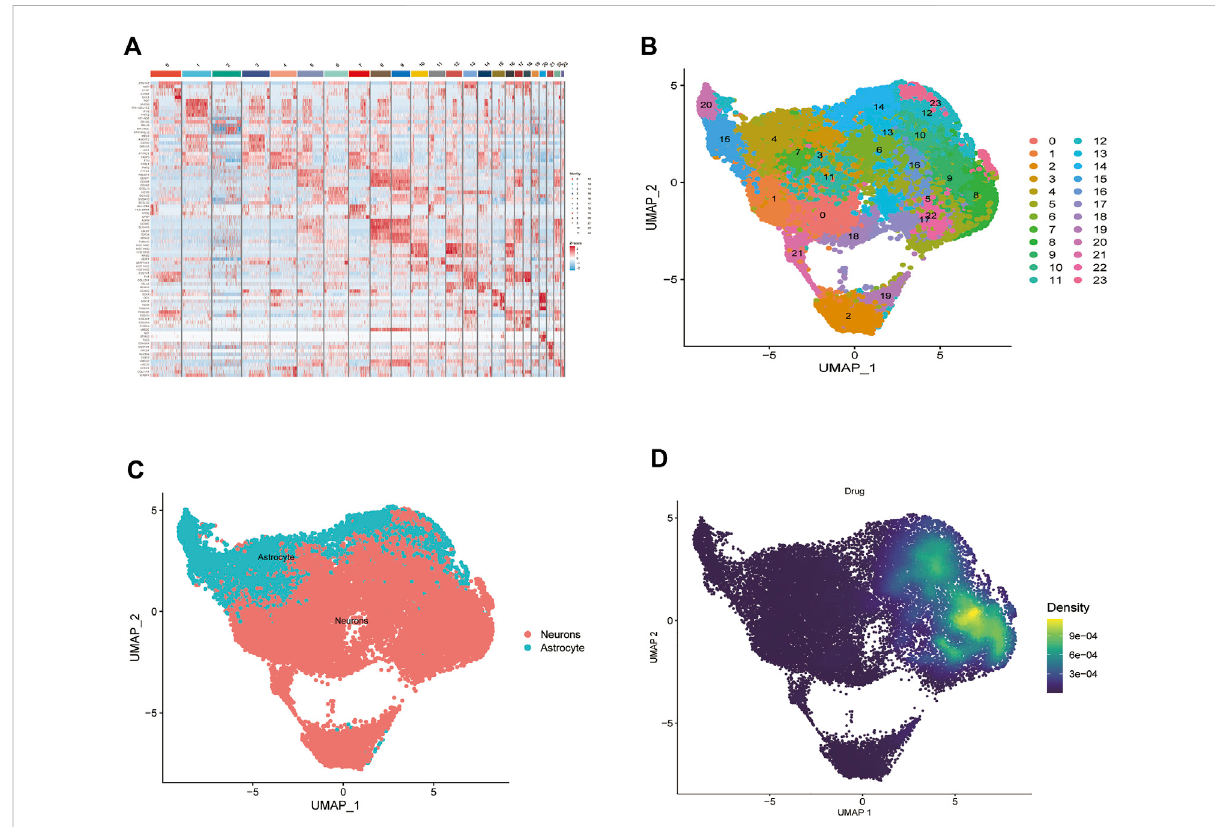
FIGURE 9 Paclitaxel pathways of action. (A) Heat map of each gene table level. (B) Uni fi ed manifold approximation and projection clustering into 24 clusters. (C) iTalk analysis identi fi ed two clusters. (D) Paclitaxel drug pathways of